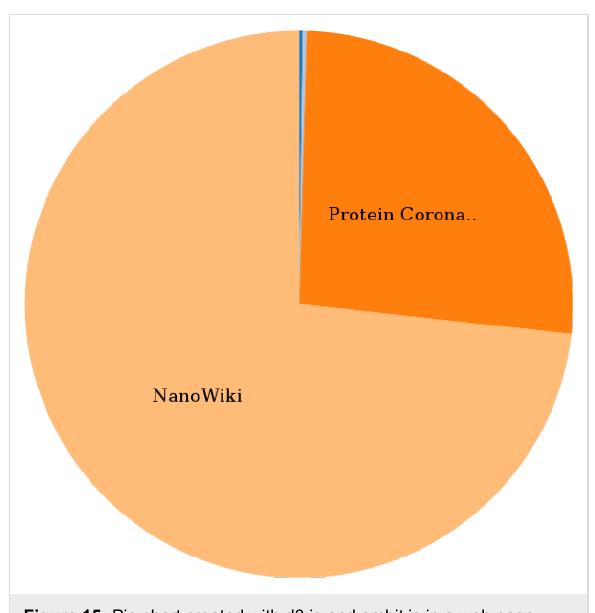
Figure 15: Pie chart created with d3.js and ambit.js in a web page showing that the NanoWiki and Protein Corona datasets contain the most nanomaterials in the database.